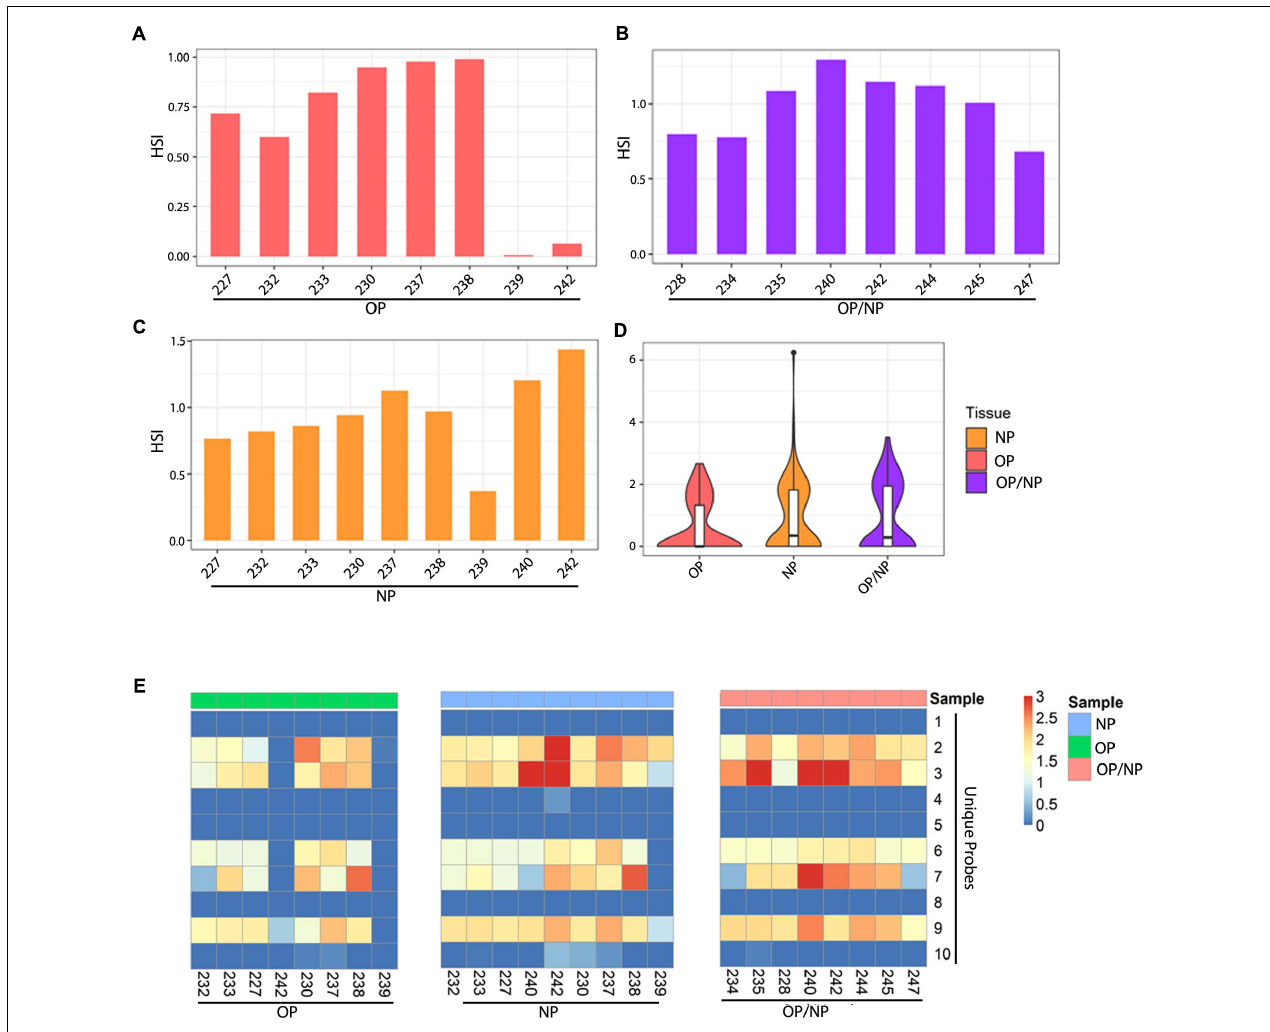
FIGURE 3 | Patient swab samples screened for SARS-CoV-2 unique probes. Bar plots showing average HSI of unique SARS-CoV-2 probes for (A) Oropharyngeal (OP), (B) Nasopharyngeal (NP), and (C) Oropharyngeal/ Nasopharyngeal (OP/NP) patient swab samples. (D) Violin plot depicting distribution of HSI for all unique SARS-CoV-2 probes for each patient swab sample type. (E) Heatmap showing HSI of SARS-CoV-2 unique probes for patient oral, nasal and oral/nasal swab